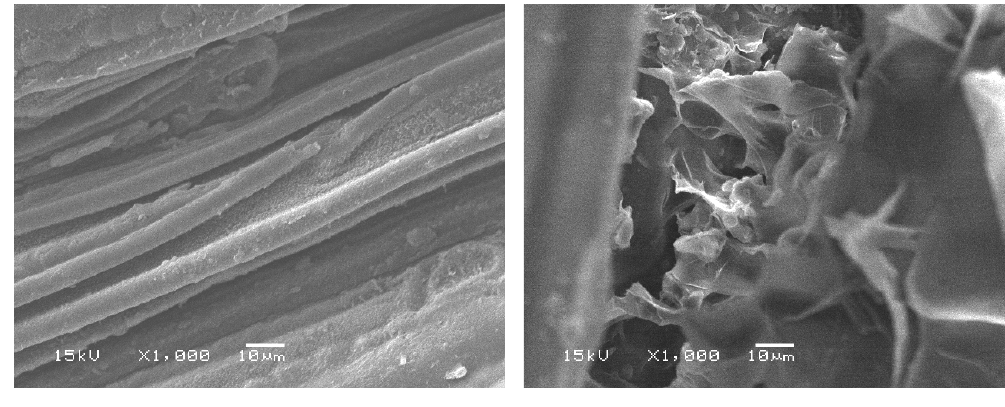
Figure 6. SEM of raw and mechanically pretreated barley.